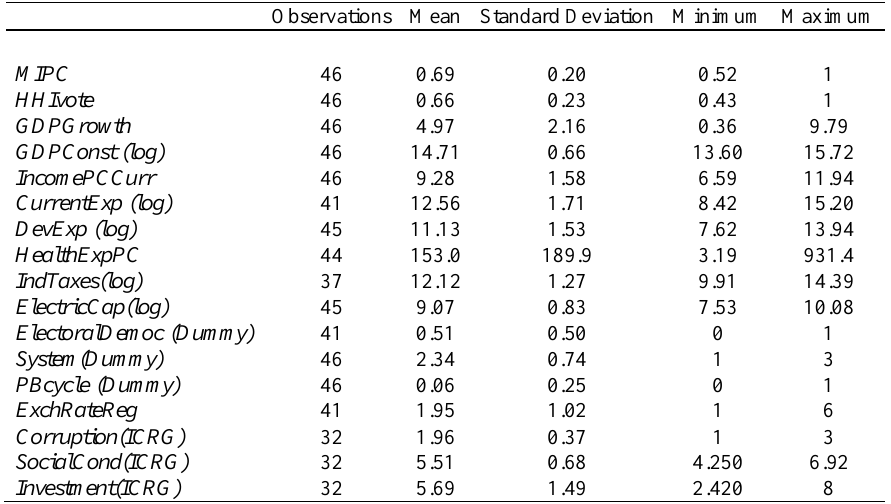
Table 1b : Summary Statistics: National